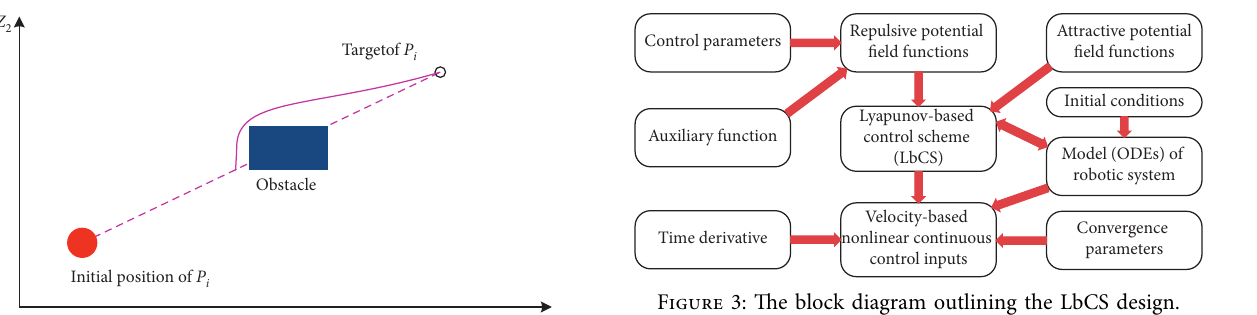
i with planar obstacle